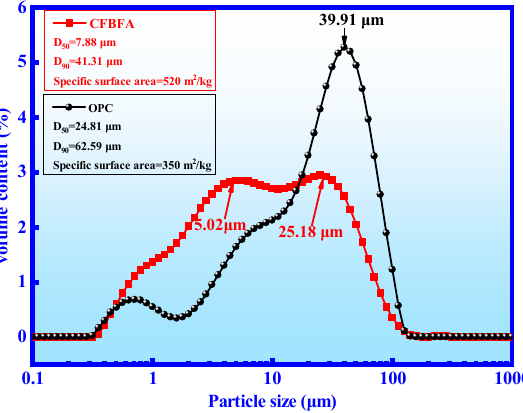
Figure 2. Particle size distribution of CFB fly ash and OPC. The microscopic morphology of CFB fly ash and OPC are provided in Figure 3. The shape of CFB fly ash particles is non-uniform. Meanwhile, many of the particles are aggregated, and the appearance of the particles possesses many distinct pores. However, the OPC particles is relatively loose, and small particles are exposed on the surface of OPC matrix, which is helpful to hydration reaction.